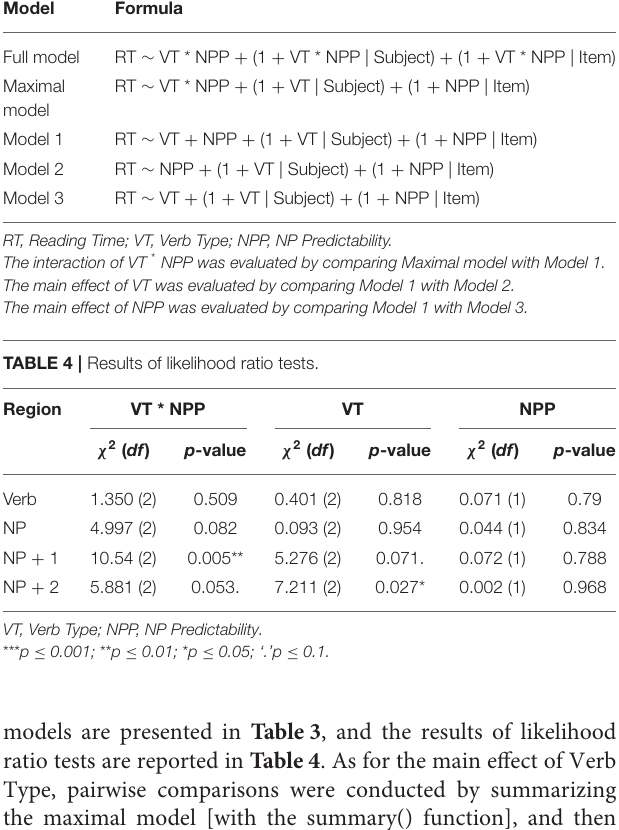
TABLE 3 | Model comparisons: likelihood ratio tests.